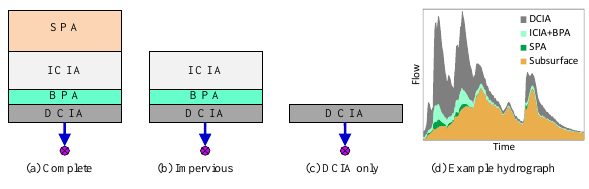
Figure 7. Conceptual representations of discrete SWMM models for hydrograph